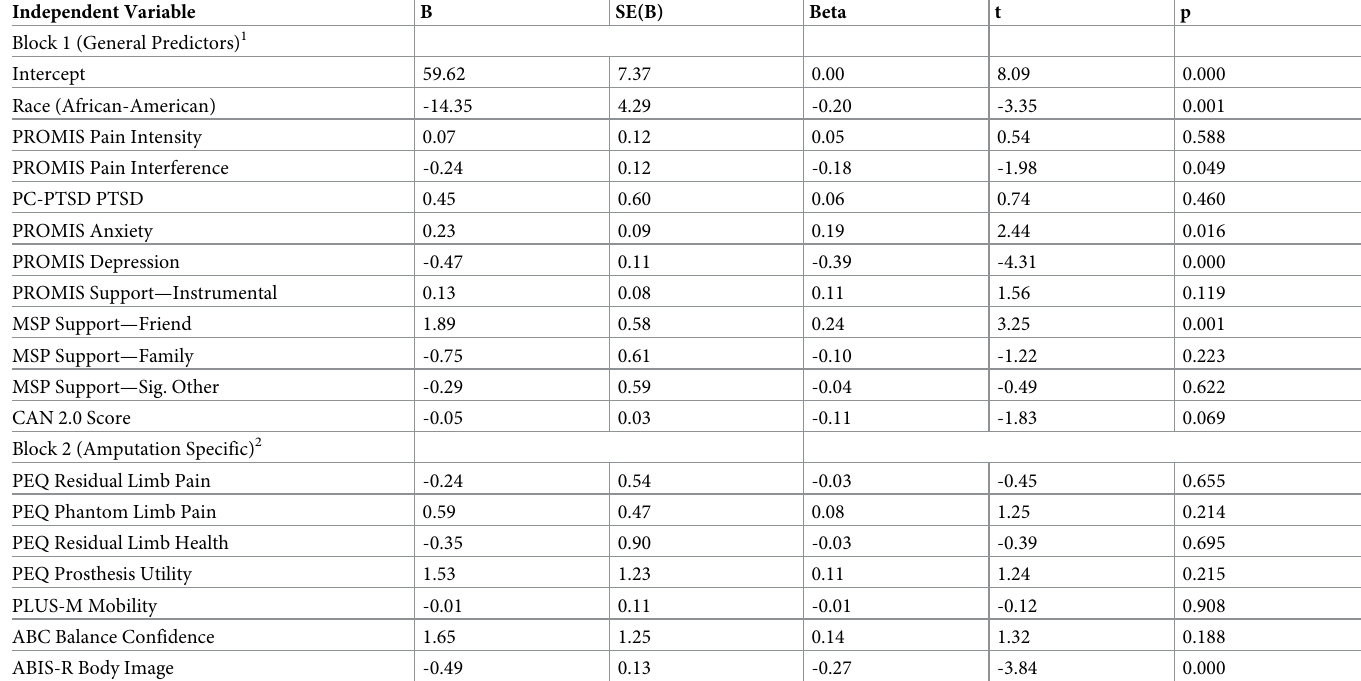
Table 4. Regression of CPI importance on general and specific